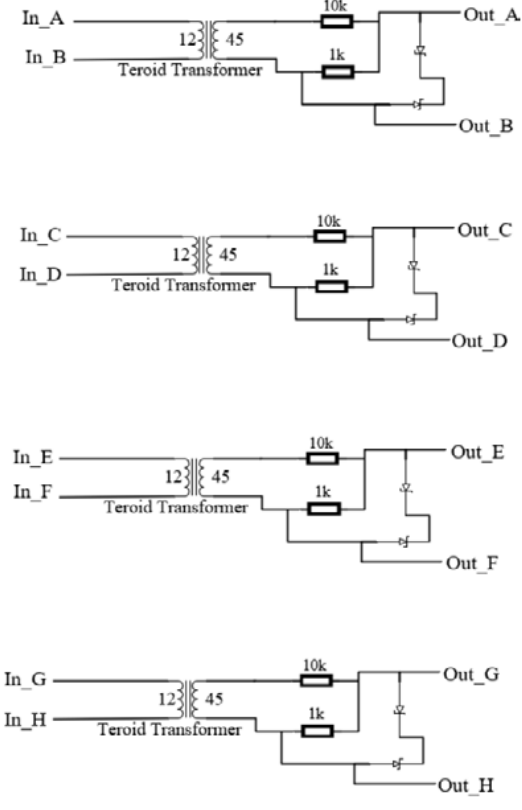
Figure 6. The pulse signal generator circuit.